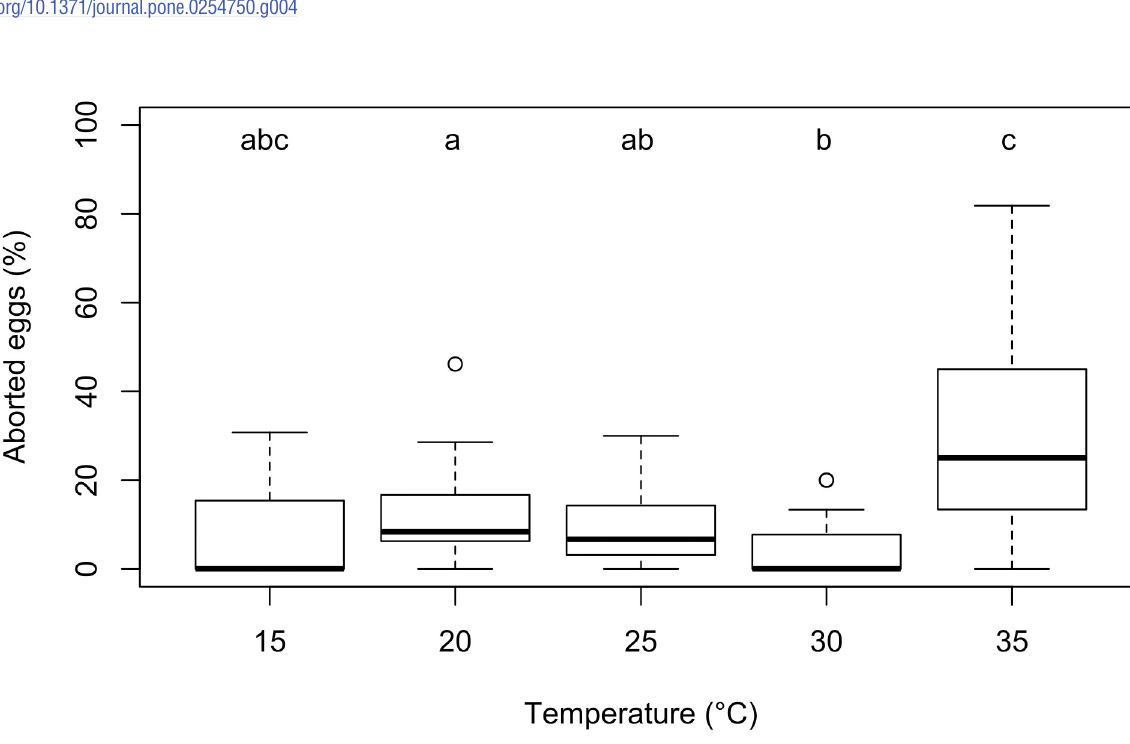
PLOS ONE | https://doi.org/10.1371/journal.pone.0254750 July 21,